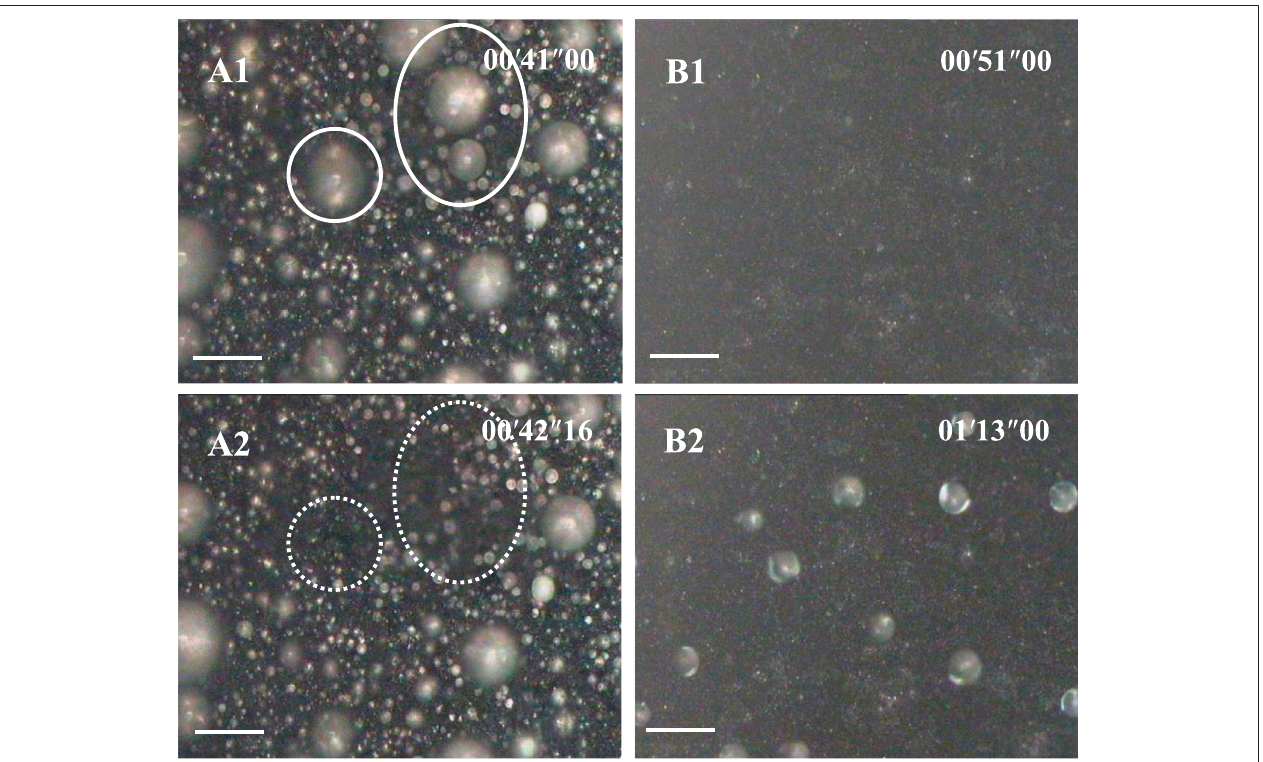
FIGURE 2 | Water vapor condensation behavior on SHS with submicron rectangle microstructures (A) series (implying Cassie or jumping condensation), and on SHS with coral- like micro/nano-structures (B) series, implying an anti-condensation character). The scale bar is 60 μ m. The temperature of SHSs was 0 – 1 ° C. The environmentalRHwas80±2%(28±1 ° C).Thetimescaleintheimagesisminute,second,andmillisecond. SupplementaryVideoS1,S2 correspondingtoAandBare available in the Supporting